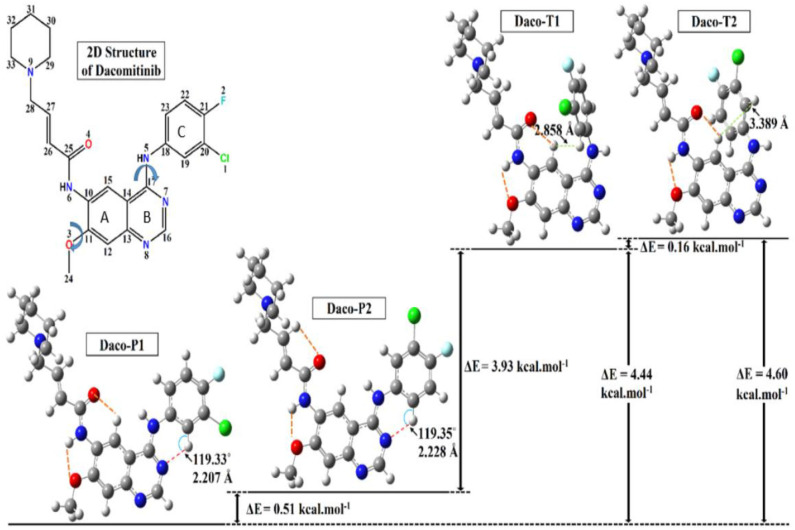
The optimized three-dimensional (3D) structures of the Dacomitinib conformers obtained from the search around the crystal structures are given along with their relative energies. In the 3D structures of Dacomitinib conformers, atoms of carbon, hydrogen, nitrogen, oxygen, chlorine, and fluorine are denoted by gray-, white-, blue-, red-, green-, and cyan-colored atoms, respectively. The energy difference between the most table minimum energy structure (Daco-P1) and the crystal structure (1C9) is 91.15 kcal·mol−1.